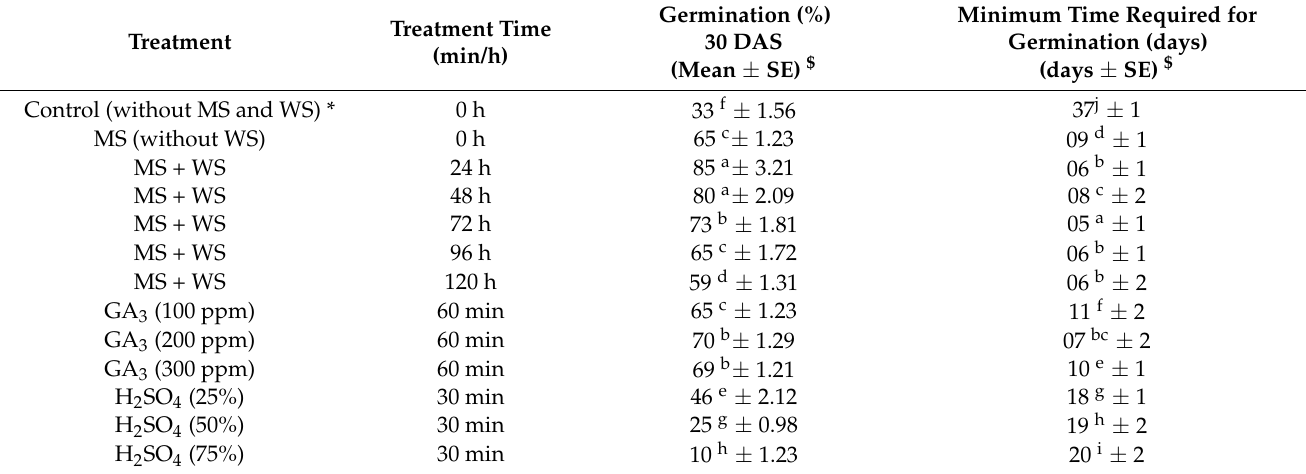
Table 2. Effect of physical and chemical treatments on seed germination of G. superba in in vitro condition 30 days after sowing (DAS) ( n =